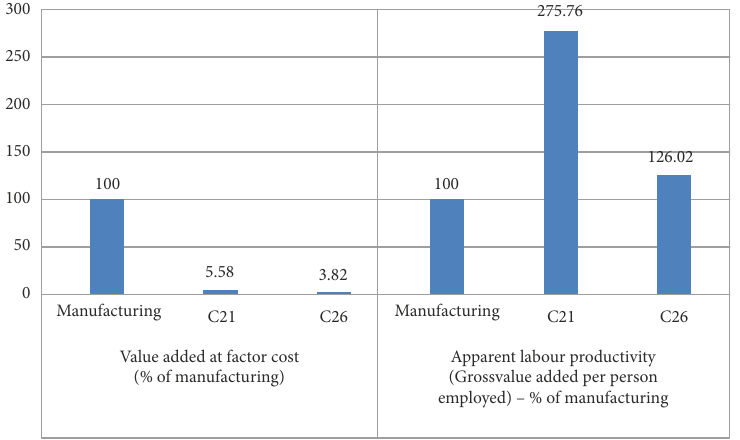
Note : Only countries that have data reported for 2018 were considered in computation for C26 (without Ireland, Cyprus, Latvia, Luxembourg, Figure 7. High-tech manufacturing performance, 2018 (source: author computation based on Eurostat, 2021)